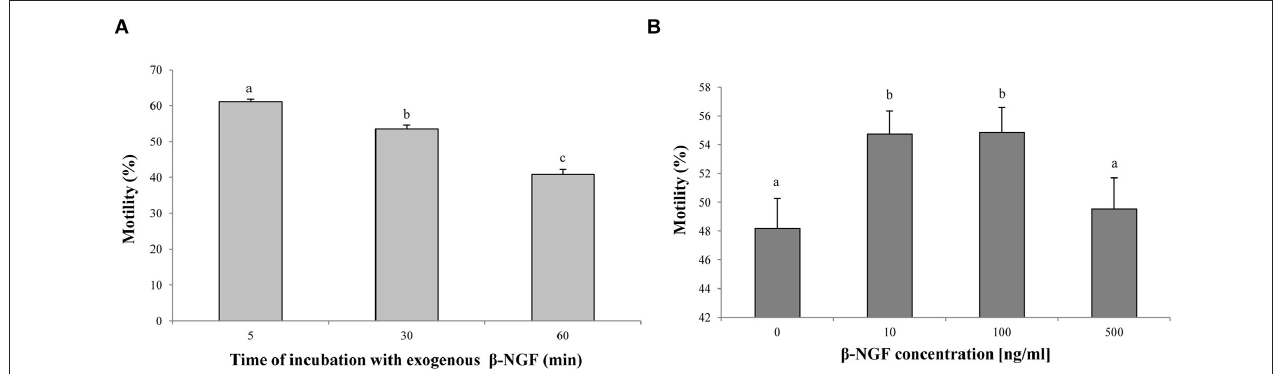
FIGURE 2 | Effect of β -NGF on llama sperm motility after cooling. (A) Incubation time-effect ( p < 0.05, n = 48 for each time point). (B) Concentration effect ( p < 0.05, n = 36 for each treatment). Results are expressed as mean ± SE. a,b Different letters indicate significant differences.